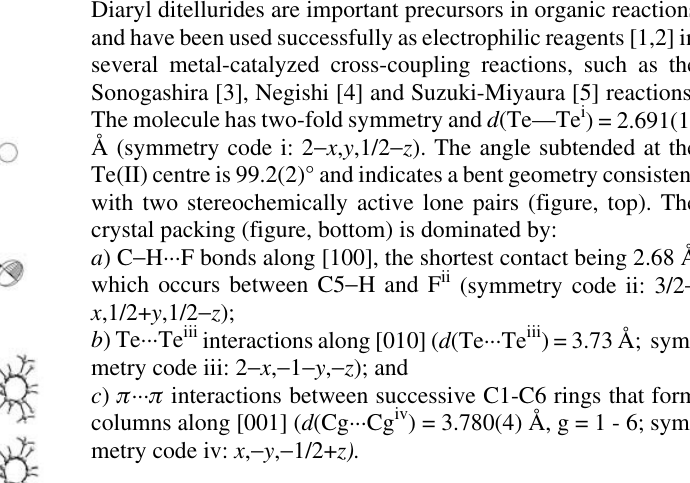
Table 1. Data collection and handling.